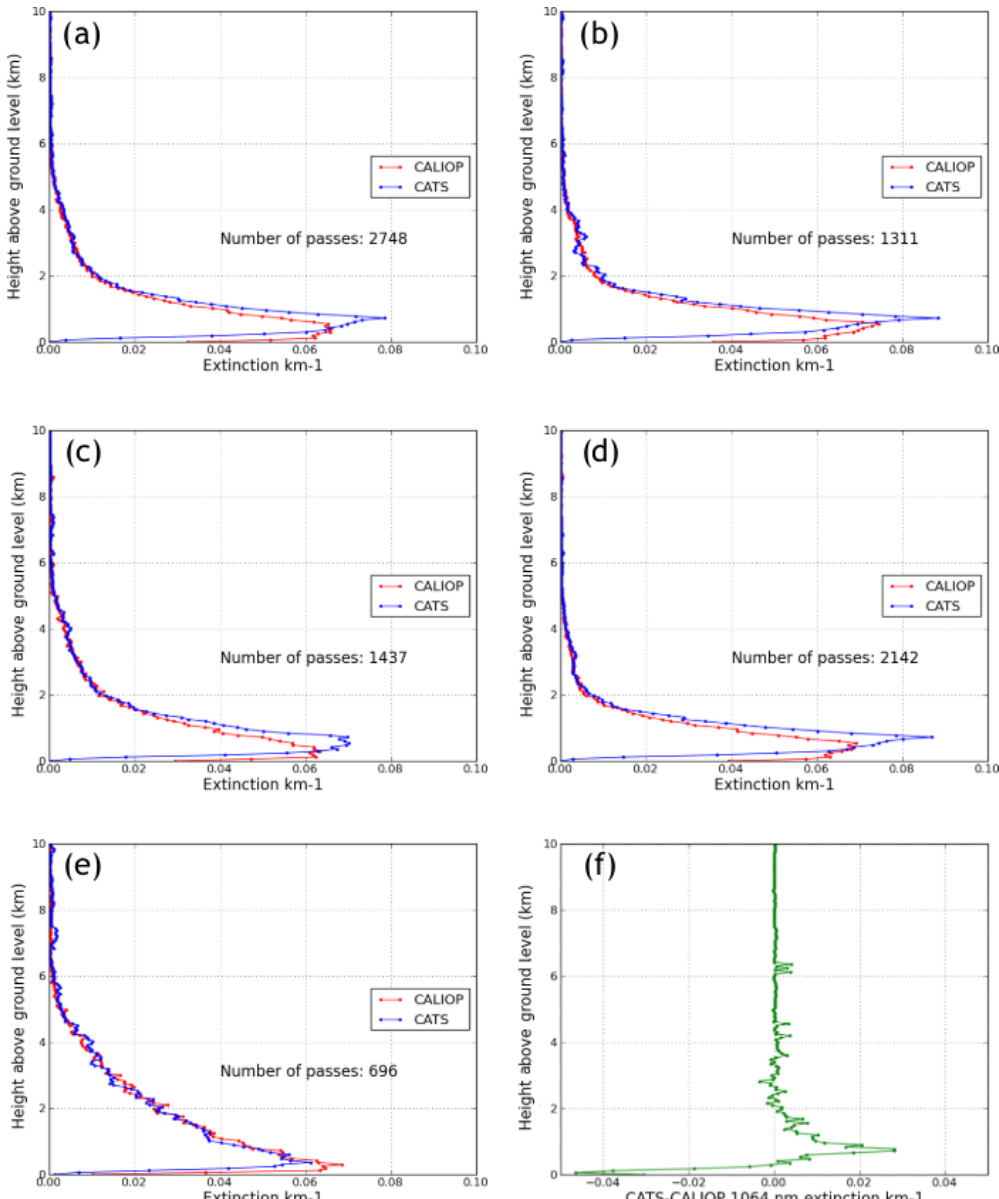
Figure 5. CATS and CALIOP vertical profiles of 1064nm extinction for (a) all profiles, (b) daytime only, (c) nighttime only, (d) over water and (e) over land (including coastal profiles). Panel (f) shows the difference between CATS and CALIOP mean 1064nm extinction for all collocated profiles (5a) as a function of height. Mean AOD values are as follows: for CATS: (a) 0.094, (b) 0.091, (c) 0.098, (d) 0.088 and (e) 0.119; and for CALIOP: (a) 0.093, (b) 0.092, (c) 0.093, (d) 0.084 and (e)